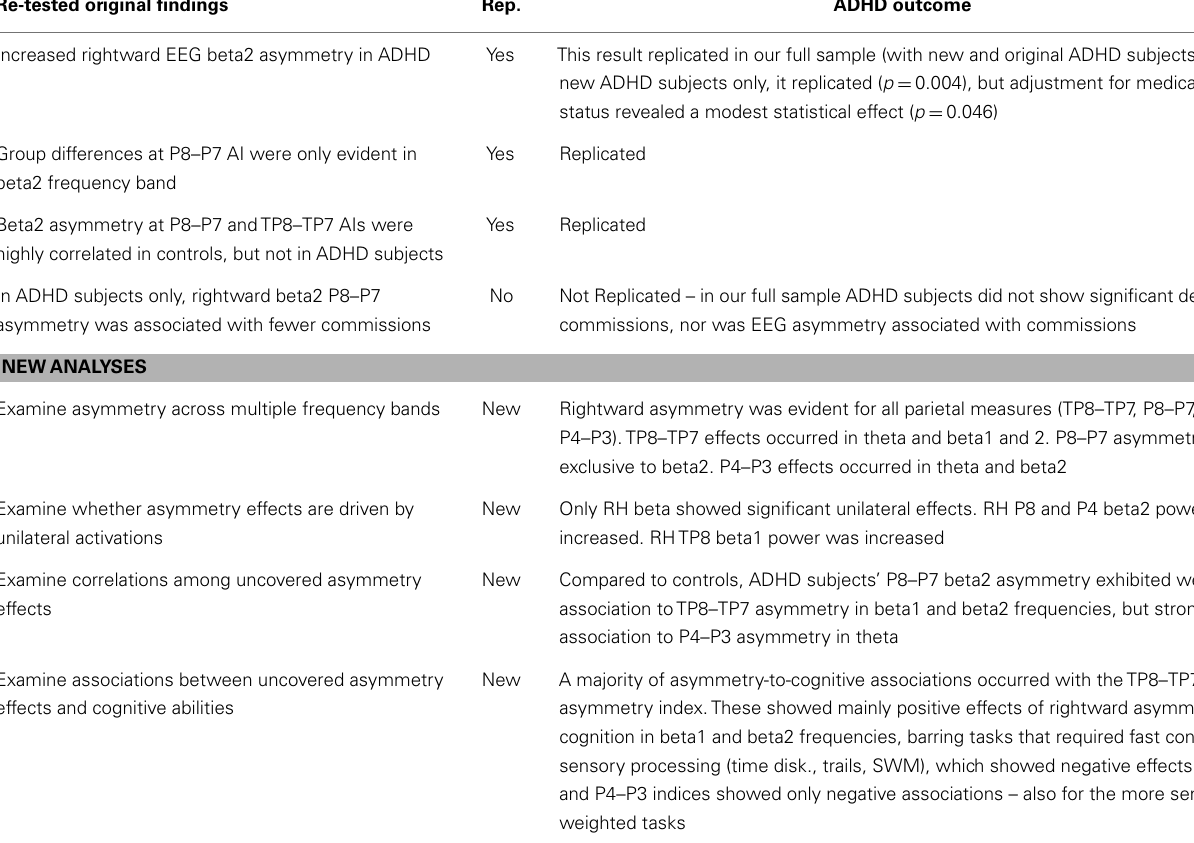
Table 10 | Results summary